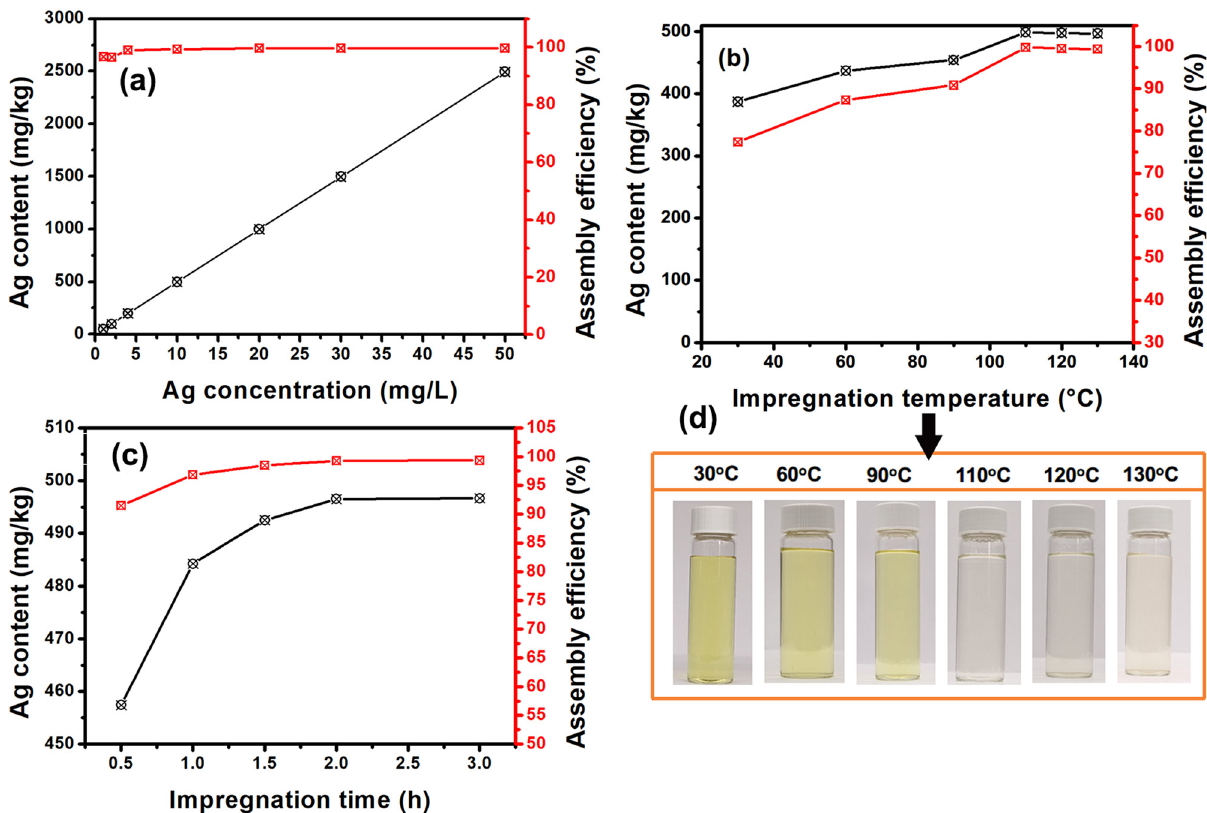
Figure 3: Adsorption of AgNPs by polyester fi bers as a function of ( a ) impregnation concentration ( impregnation temperature: 110°C; impregnation time: 2 h ) , ( b ) impregnation temperature ( impregnation concentration: 10 mg/L; impregnation time: 2 h ) , and ( c ) impregna - tion time ( impregnation concentration: 10 mg/L; impregnation temperature: 110°C ) . ( d ) Photos of the residual solution of AgNPs after AgNPs were adsorbed by polyester fi bers.